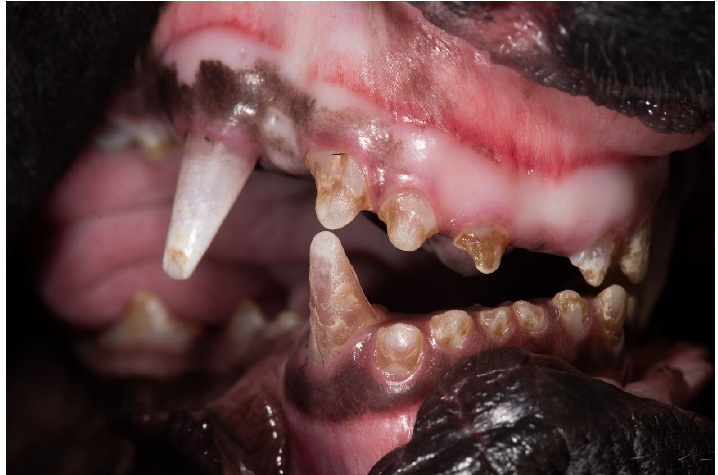
Figure 1. Oral cavity of a DSRA affected Cane Corso dog. All teeth appear translucent and show marked brown discoloration with multifocal enamel defects. Used with permission Utrecht University.